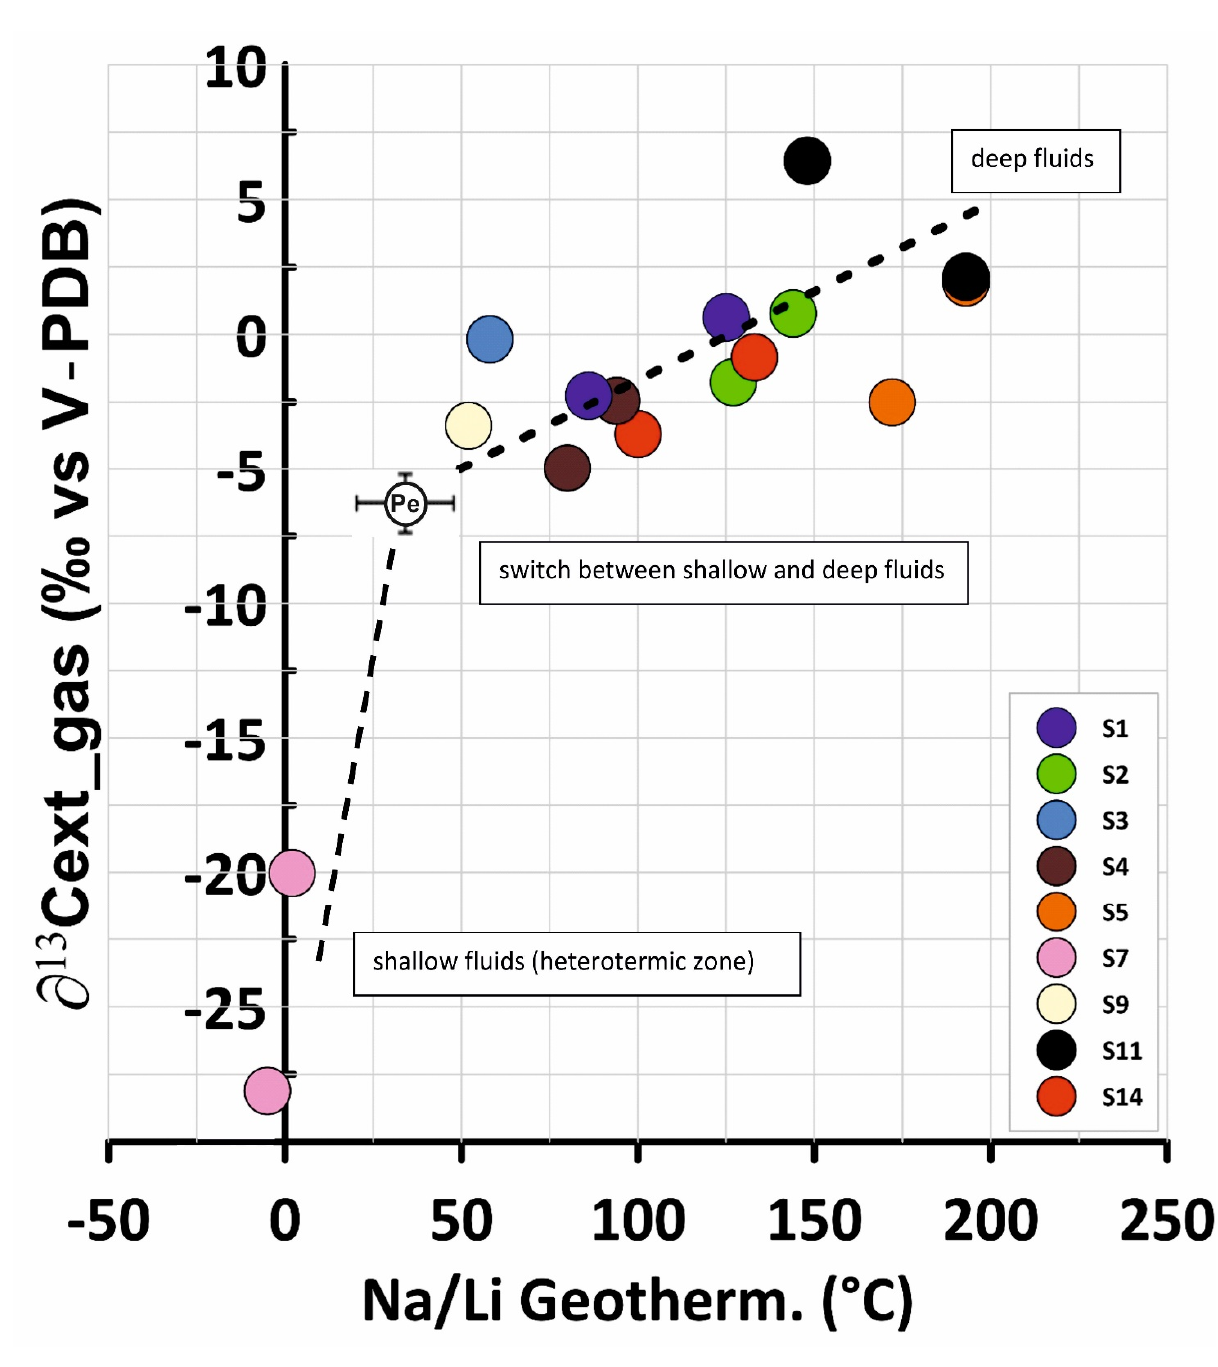
Figure 4 . δ 13 Cext versus T, where T = temperature in °C obtained from an Na-Li geothermometer [96]. δ 13 Cext was calculated only for some groundwater samples from the San Vittorino Plain (displayed with circles), whose (δ 13 C DIC ) was measured. Historical data from the S10 Peschiera “Pe” spring are also shown for comparison (see also Figure S2). See Figure 1 for spring location.